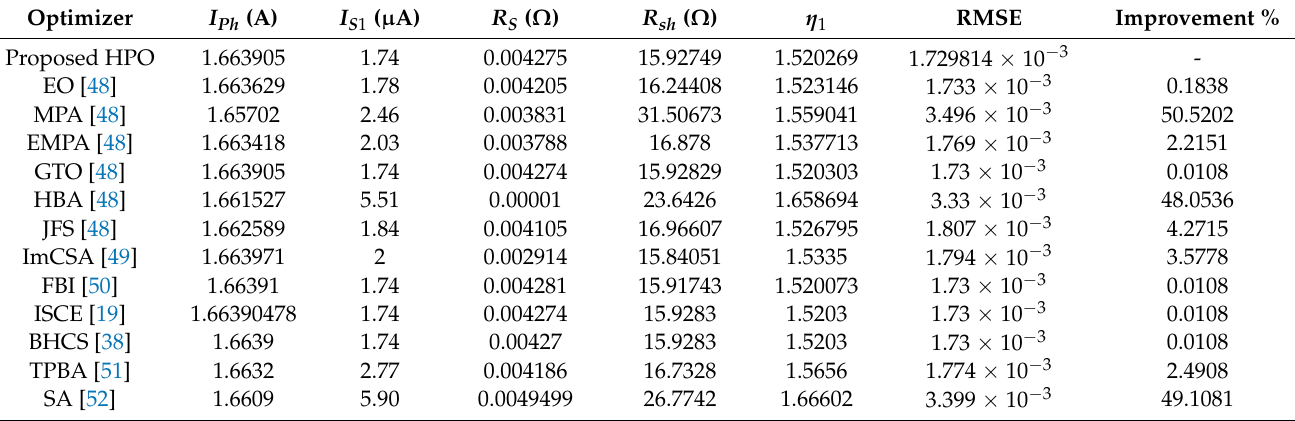
Table 2. Optimal results of the HPO and other reported techniques for the single-diode model of